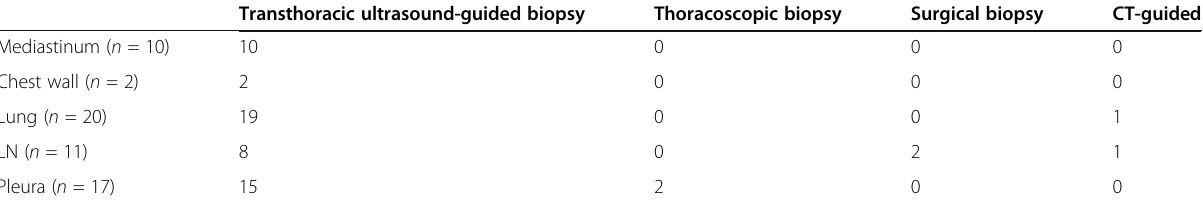
Table 11 Methods of histopathologic confirmation in the study population